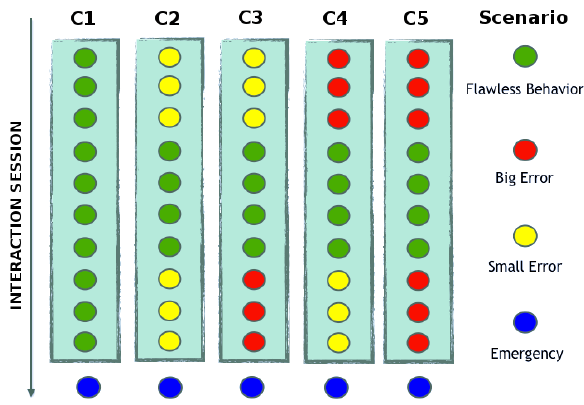
Figure 1: Experimental conditions with different scenarios pre- sented to the